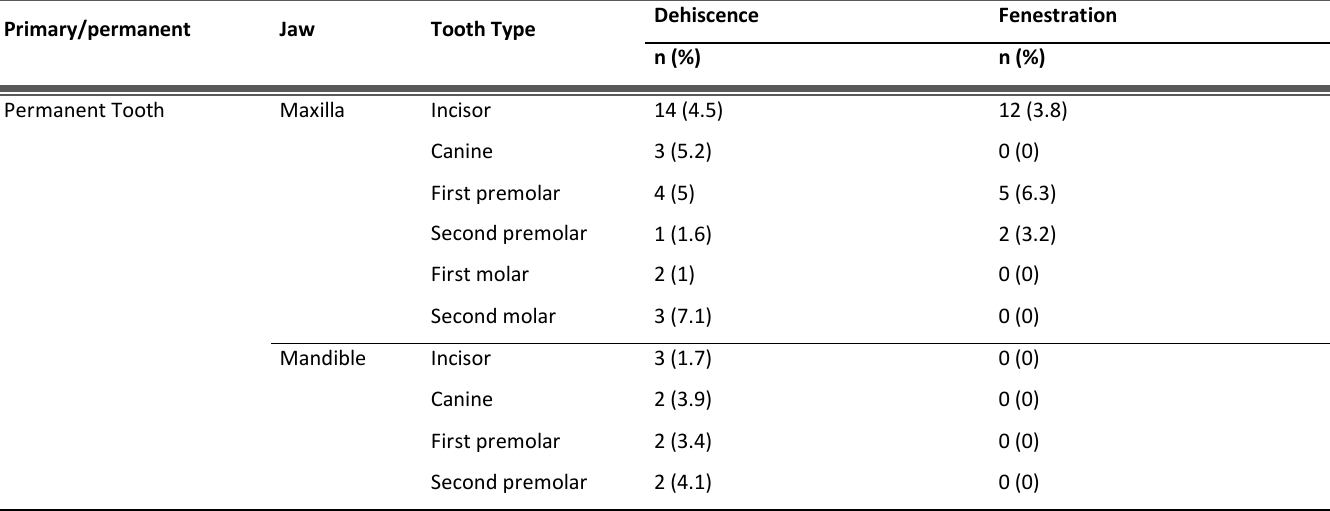
Table 3. Frequency of dehiscence / fenestration, based on tooth